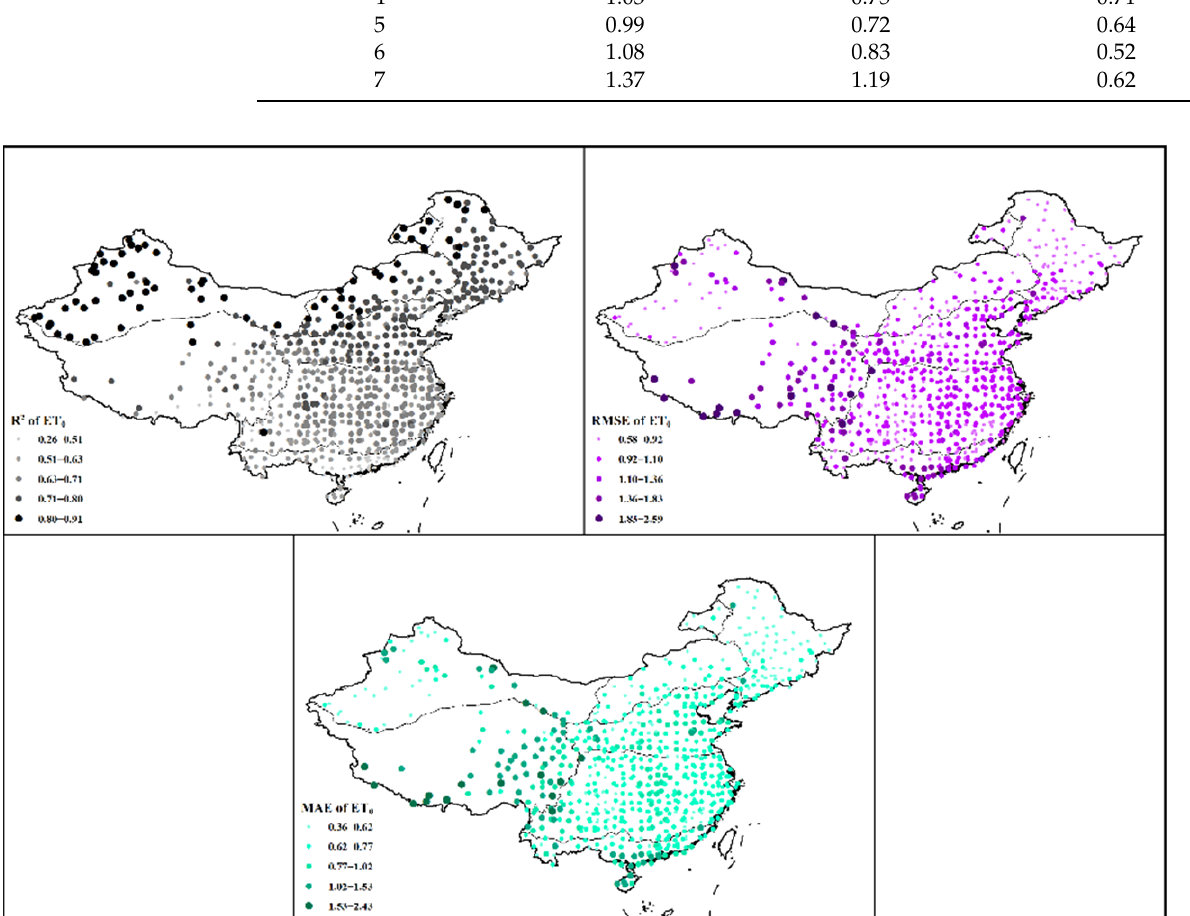
Figure 5. Spatial distribution of ET 0 statistical indicators.